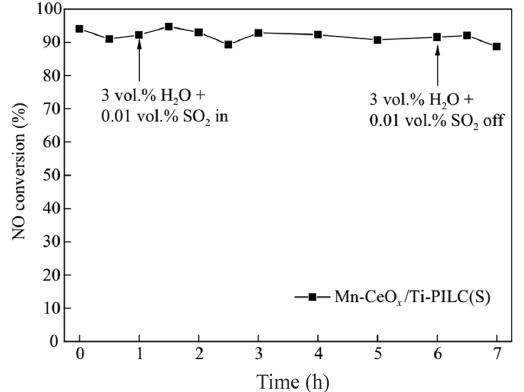
Figure 23. Effect of H 2 O and SO 2 on NO conversion over Mn–CeO x /TiPILC(S) at 200 °C (Reaction conditions: 0.06 vol % NO, 0.06 vol % NH 3 , 3 vol % O 2 , 3 vol % H 2 O (when used), 0.01 vol % SO 2 (when used), balance N 2 , GHSV 50,000 h − 1 , total flow rate 300 mL/min). (Reproduced with permission from Reference [44], Copyright 2012, Science Direct.).